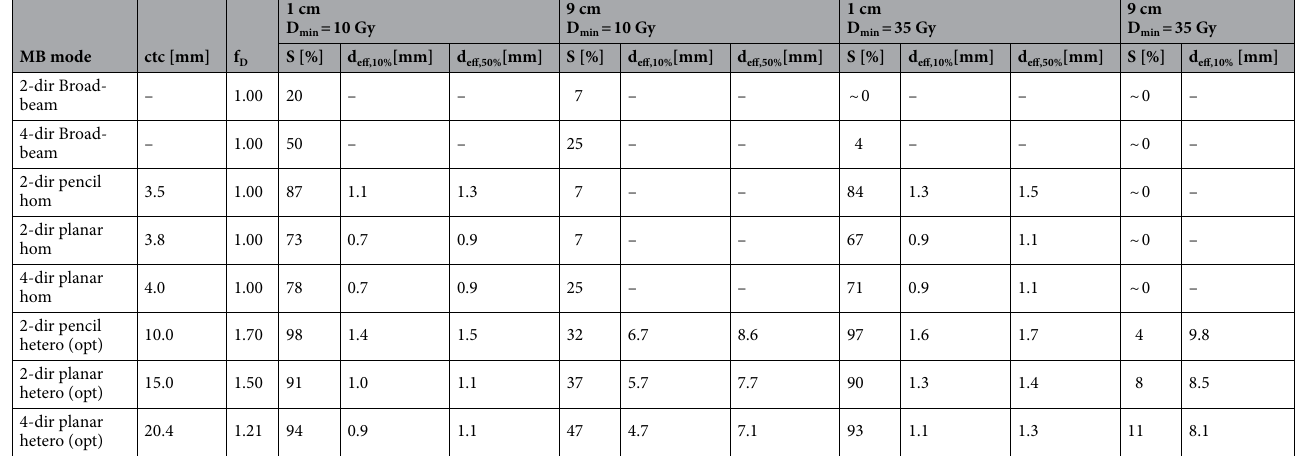
Table 1. Comparison of different interlacing minibeam modes with 2-Gaussian approximation. For each minibeam mode, the homogeneous tumor irradiation and the optimum heterogeneous tumor irradiation is presented. The mean cell survival (S) and biologically effective beam size (d eff ) for D min = 10 and D min = 35 Gy (minimum) tumor dose are given for 1 cm and 9 cm depth. The survival fractions of 10% or 50% are taken for determination of the effective beam sizes d eff,10% and d eff,50% . Values marked by a dash (–) cannot be determined.